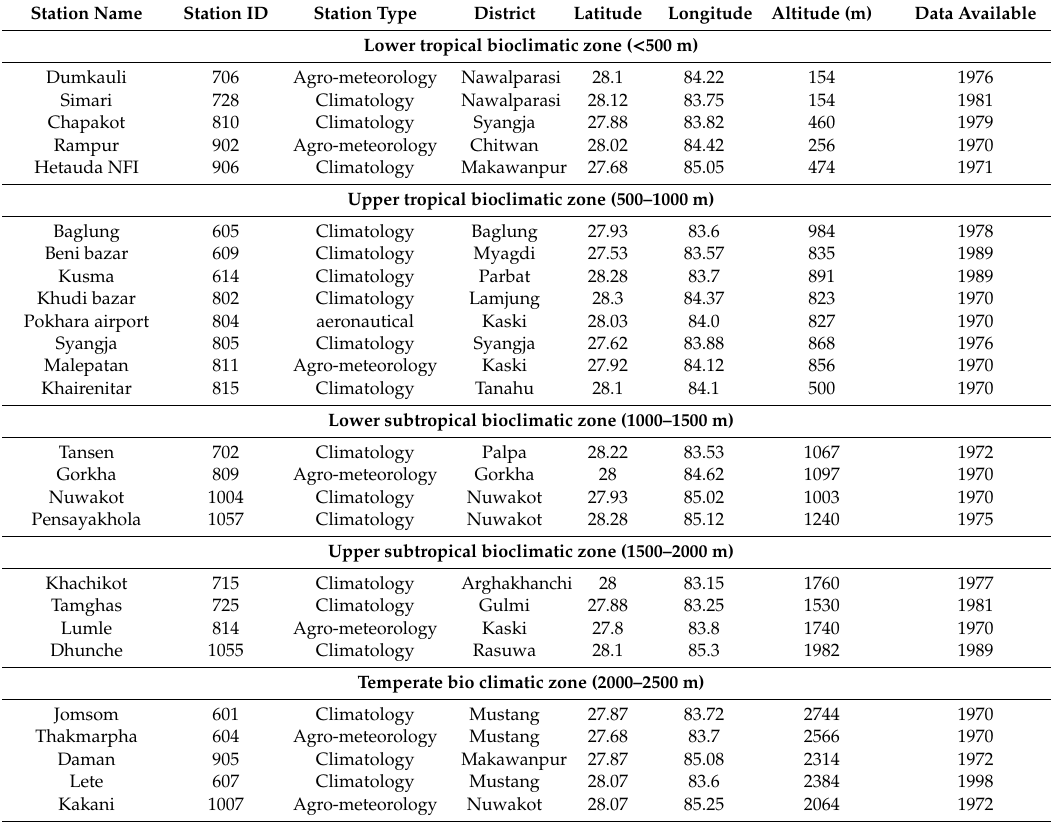
Table A1. Stations used to analyze the temperature trends in CHAL, 1970–2019.